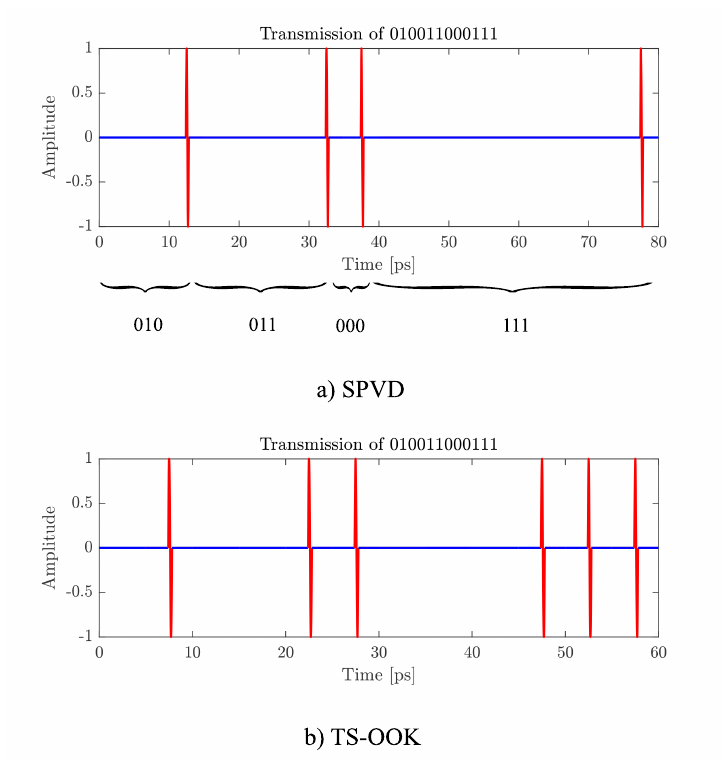
Figure 2. Waveform comparison between Single-Pulse Variable Duration (SPVD) and